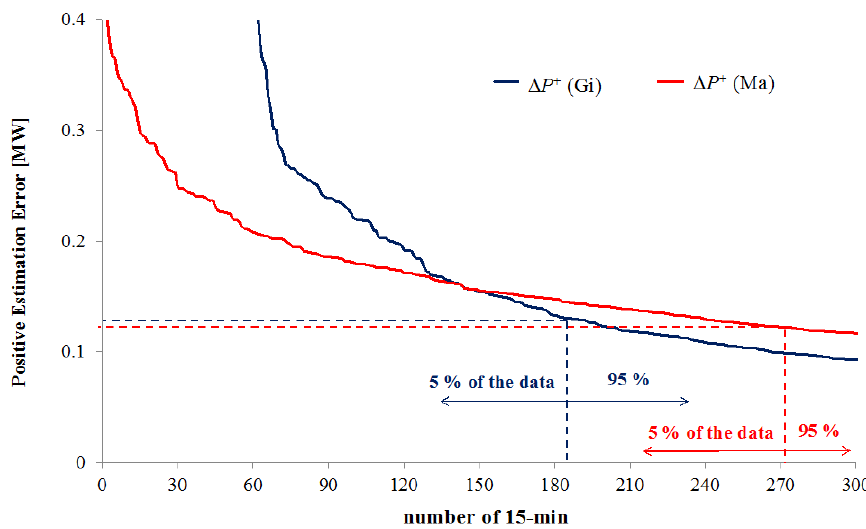
Figure 14. Zoom of the duration curves of positive estimation errors of the AC power profiles with respect to experimental results for the year 2012 at the sites “Gi” and “Ma”.